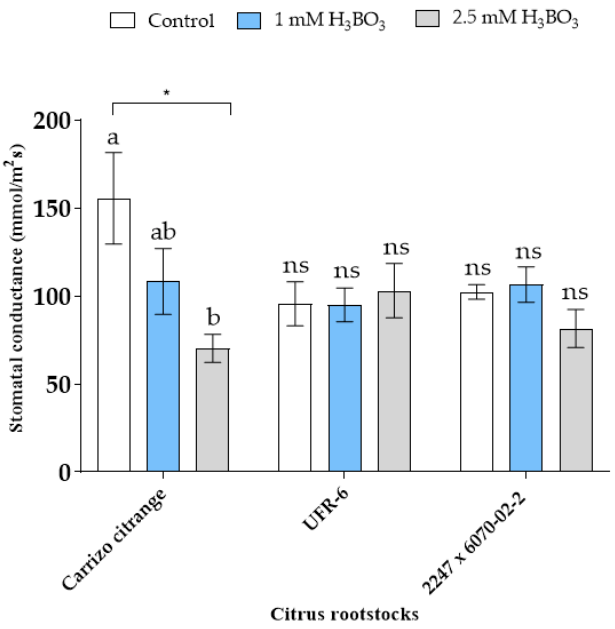
Figure 4. Mean stomatal conductance (mmol/m 2 s) at the end of the experiment with three boron toxicity treatments (Control, 1 mM H 3 BO 3 and 2.5 mM H 3 BO 3 ) and using three citrus rootstocks (Carrizo citrange, UFR-6 and 2247 x 6070-02-2). Values in columns with different letters means statistical differences among the treatments per each rootstock by Fisher LSD test ( p < 0.05). Significant codes: * = p < 0.05; ns: non-significant differences.